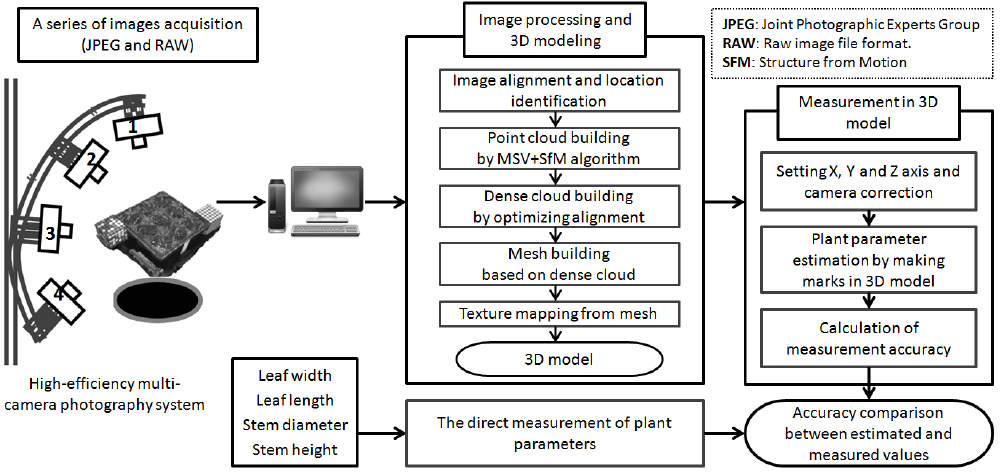
Figure 1. MCP-SfM system and the overall workflow for 3D modeling and measurement.